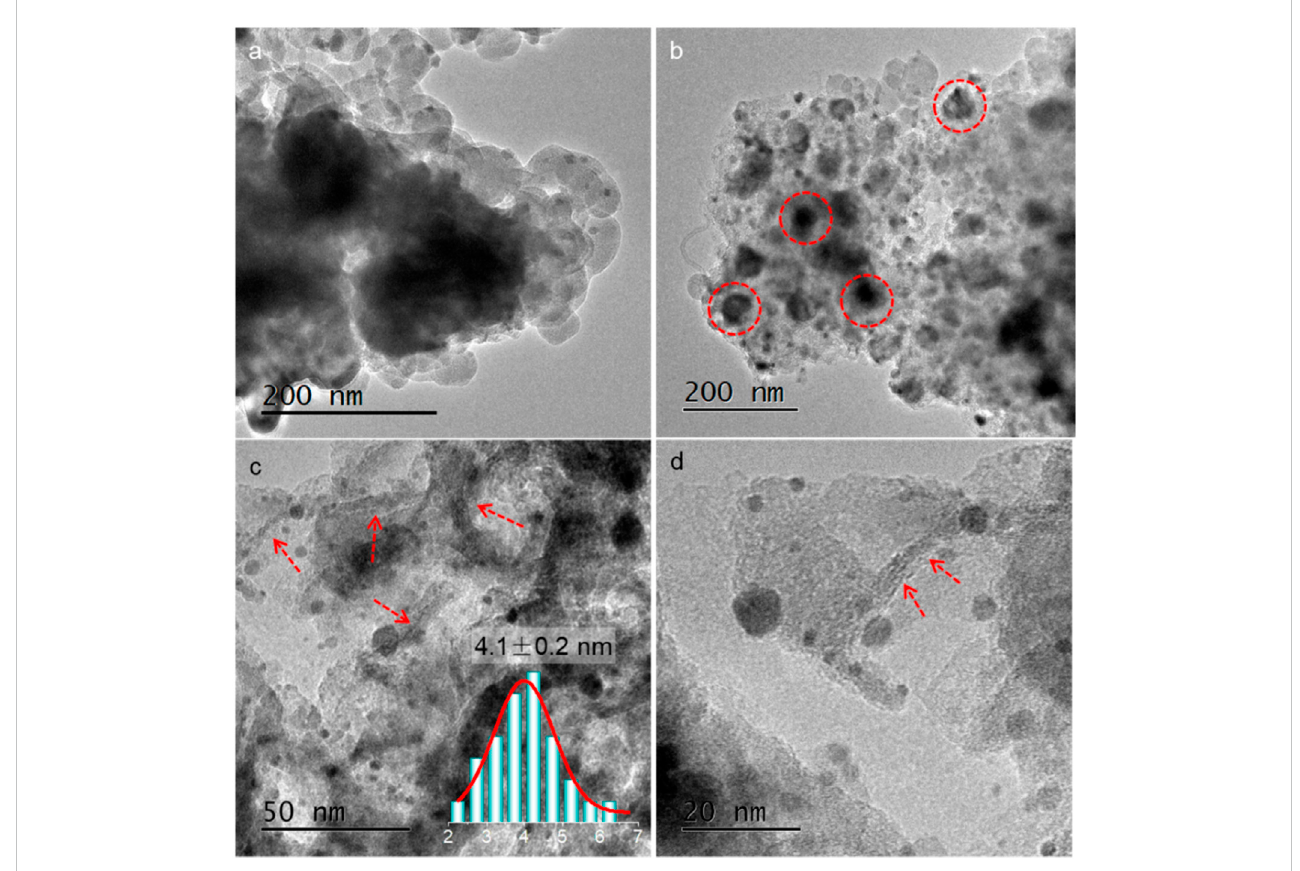
TEM images of (A) SiO 2 @ZIF-Ar after Ar thermal treatment, (B) (Si)C-NaOH after NaOH etching, and (C , D) Au/(Si)C after gold loading and